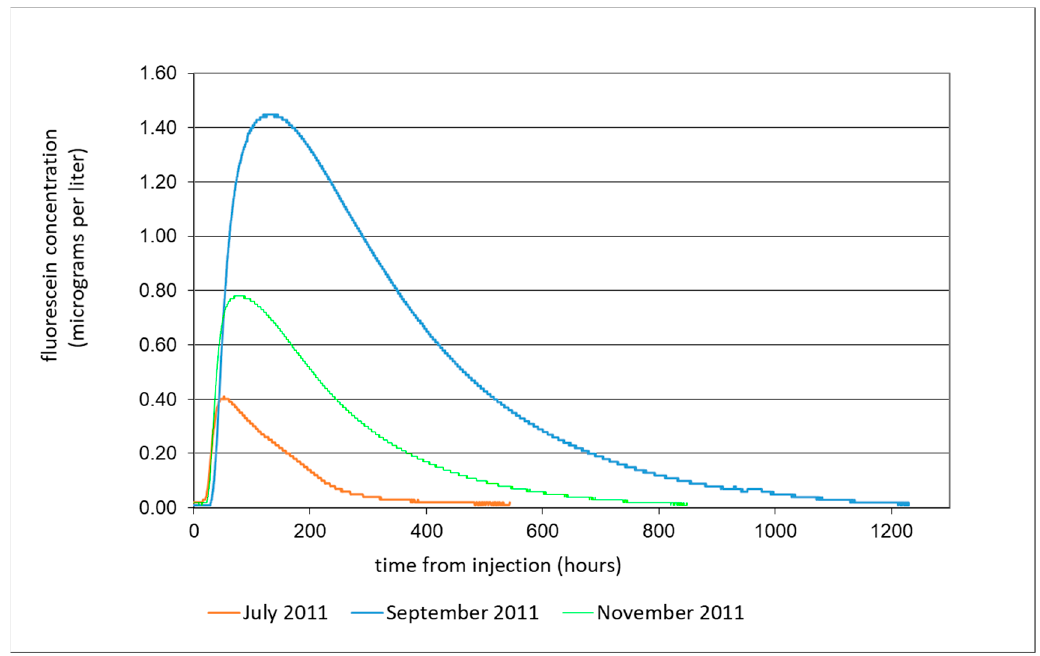
Figure 13. Dye breakthrough curves for the three fluorescein tracer tests performed.